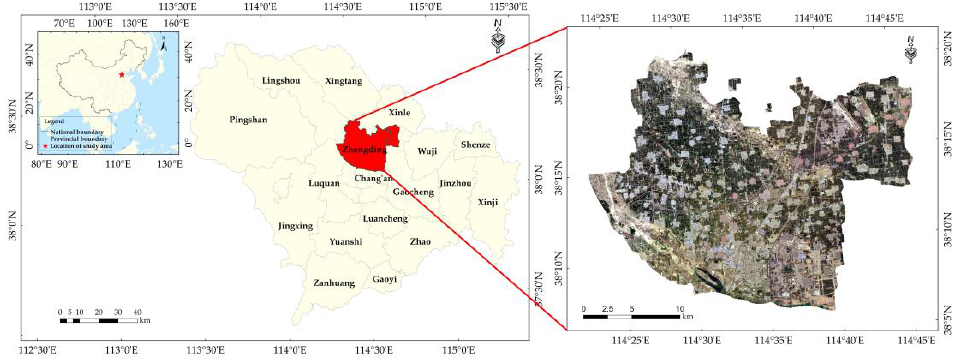
Figure 1. Geographic location of the study area using a Sentinel-2 remote sensing image.